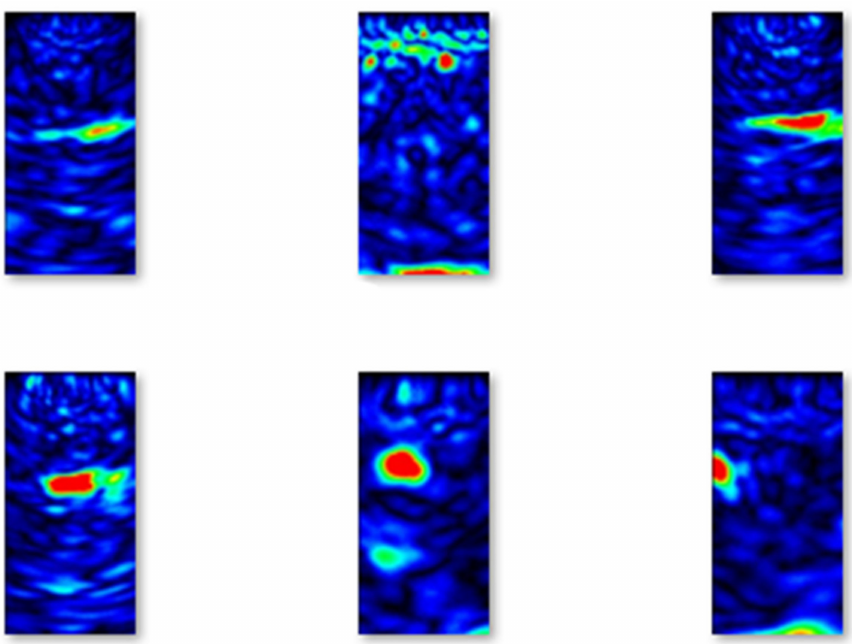
Figure 8. Examples of B-scans with flaws from the validation